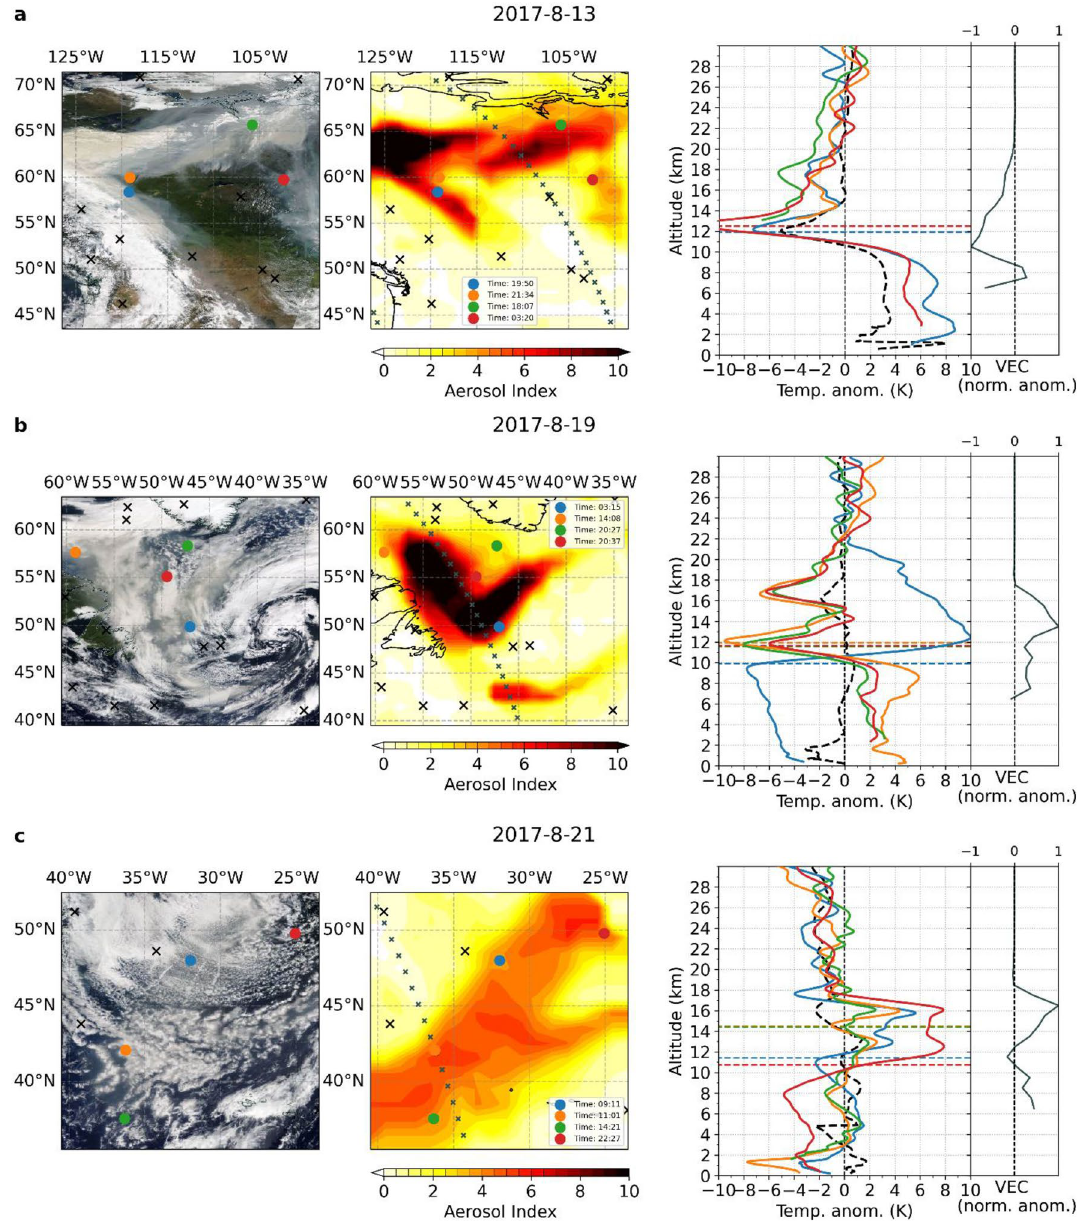
Figure 2. Temperature imprints of the Northern American wildfire plume on different days during its early evolution. MODIS satellite image (left), aerosol index (AI) (center), and RO temperature anomaly profiles (right) located inside the plume (colored lines, right) as well as the mean temperature anomaly profile outside the plume (dashed line) along with OMPS-LP aerosol anomalies (normalized volume extinction coefficient (VEC) relative to the monthly means from 2016 to 2020; right subpanel) for the region investigated on ( a ) August 13, ( b ) August 19 ( b ), and ( c ) August 21 in 2017. Colored dots/black crosses represent the locations of RO profiles inside/outside the aerosol cloud. Small crosses in the central plot indicate the locations of OMPS-LP measurements. Horizontal colored lines in the right plot indicate the lapse rate tropopause for each respective RO